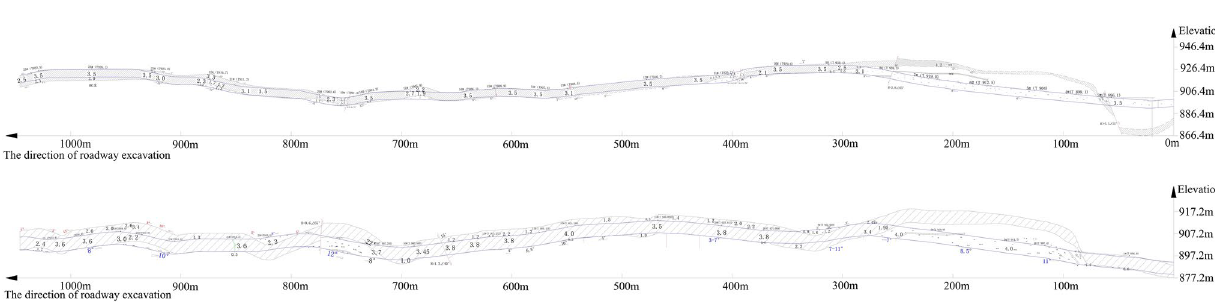
Figure 4. The elevation of coal seam floor of haulage roadway and air-return roadway (the blue line is the roof and bottom of the roadway, the shaded area is the roof and the floor of the coal